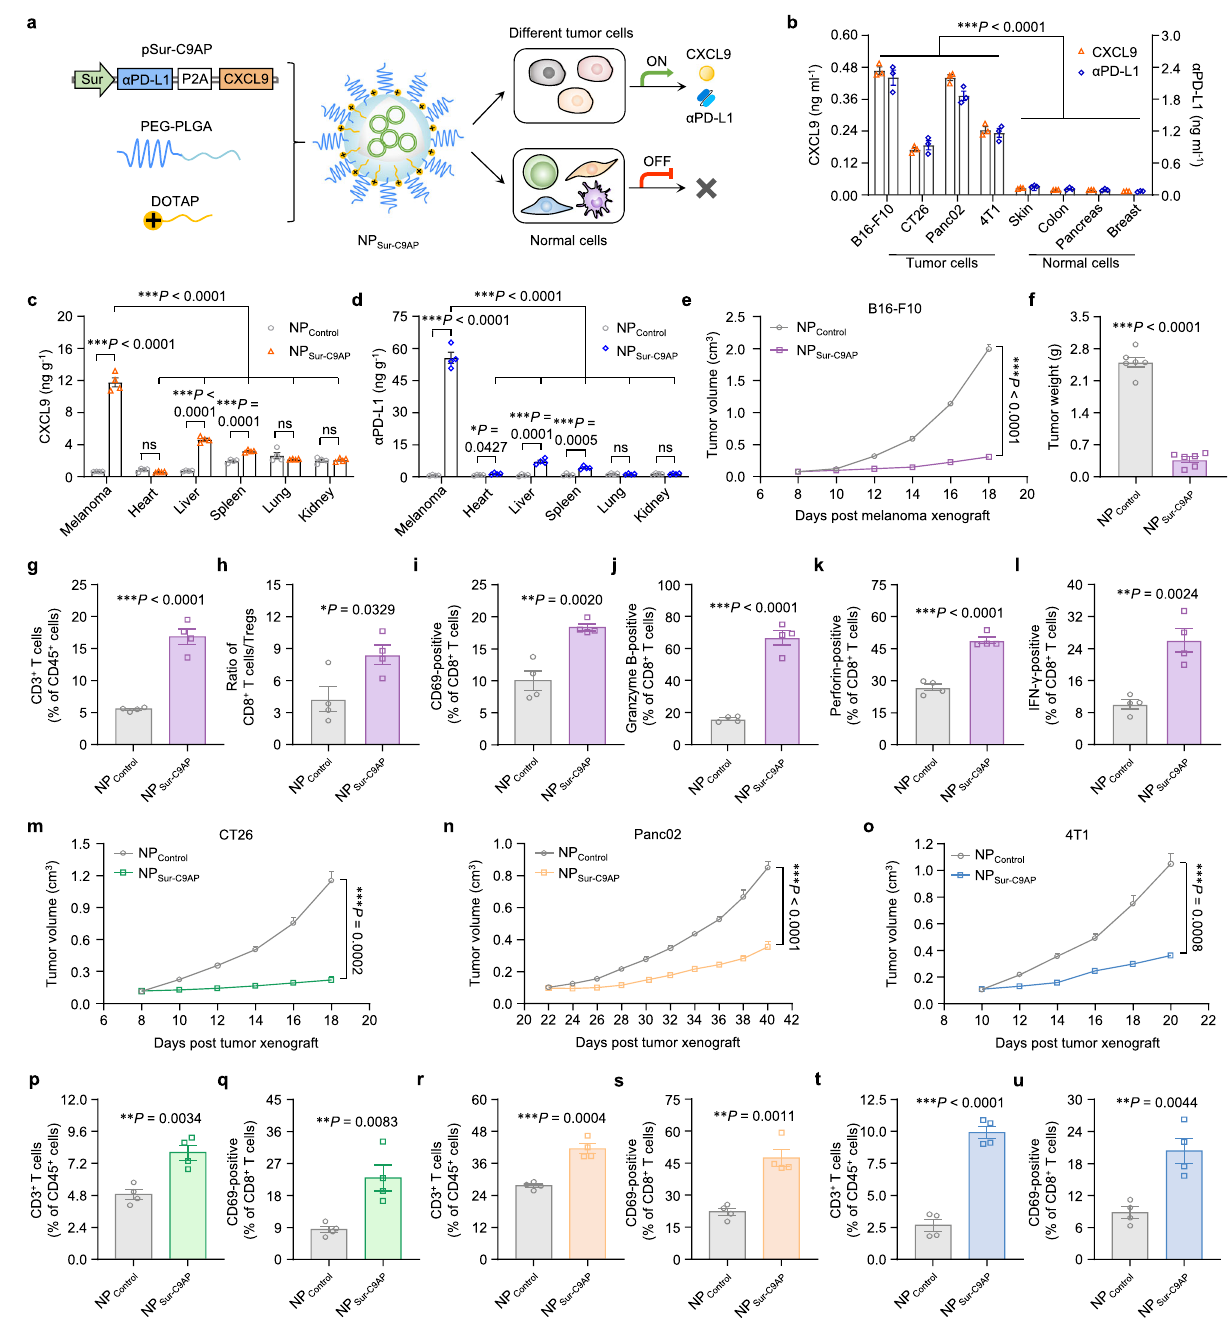
Fig. 8 | NP Sur-C9AP enhances T-cell recruitment and activation in multiple tumors for enhanced immunotherapy. a Scheme of constructing NP Sur-C9AP by encapsulating pSur-C9AP with PEG-PLGA and DOTAP. NP Sur-C9AP can deliver pSur- C9AP into different tumor cells and other normal cells, but the Sur promoter of pSur-C9APwillonlyturnon in tumor cellsto drive the coexpression ofCXCL9and α PD-L1. b Concentrations of CXCL9 and α PD-L1 proteins in the culture super- natants of four types of tumor cells (B16-F10, CT26, Panc02, 4T1 cells) and four types of primary normal cells (mouse skin, colon, pancreas and breast cells) after NP Sur-C9AP transfection. c , d ConcentrationsofCXCL9( c )and α PD-L1( d )proteinsin melanomaandnormalorgansoftheNP Sur-C9AP -treatedmice( n =4micepergroup). e , f Tumor growth curves ( e ) and fi naltumor weights ( f ) of the B16-F10melanoma- bearing mice treated with NP Sur-C9AP or NP Control ( n =6 mice per group). g , h PercentagesofCD3 + Tcells ( g ) orthe ratioof CD8 + T cells/Tregs( h ) in